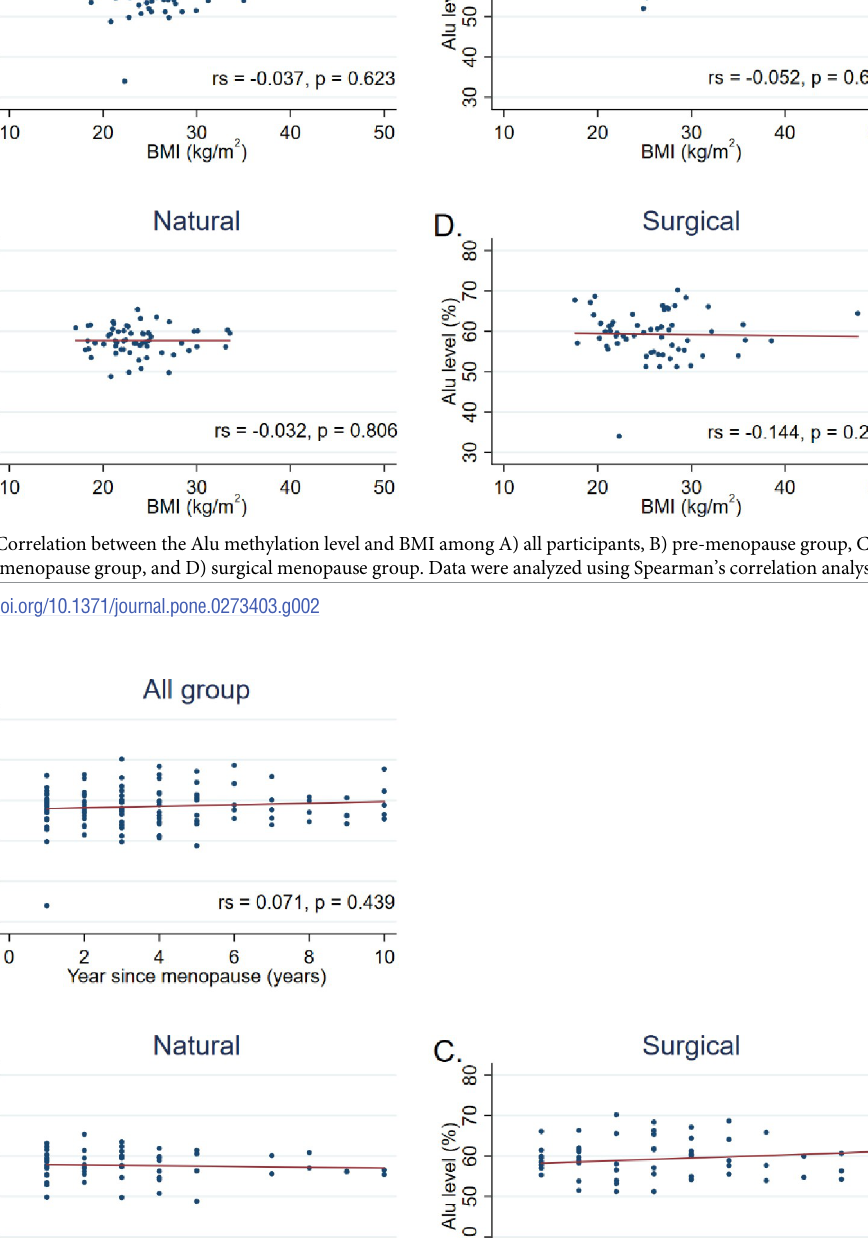
PLOS ONE | https://doi.org/10.1371/journal.pone.0273403 August 25,